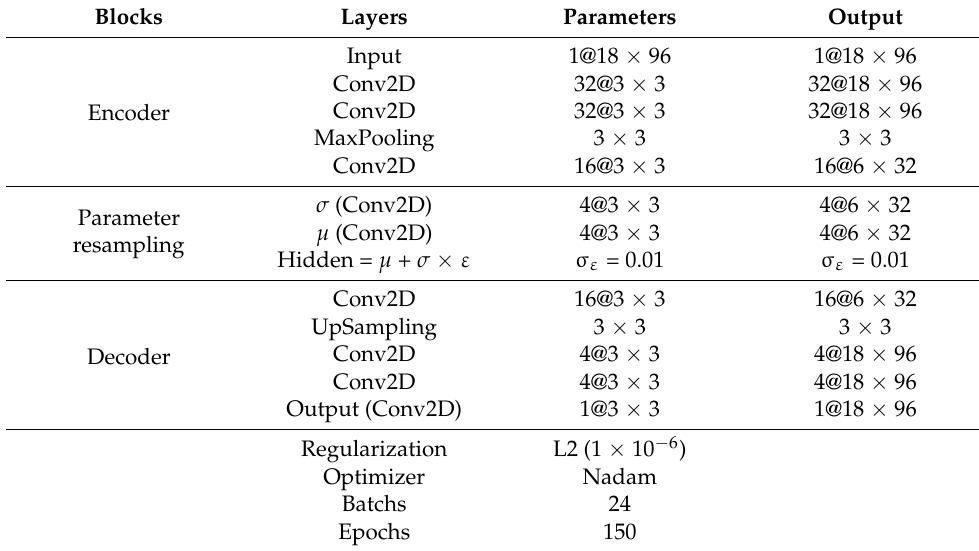
Table 4. Parameters of CVAE.